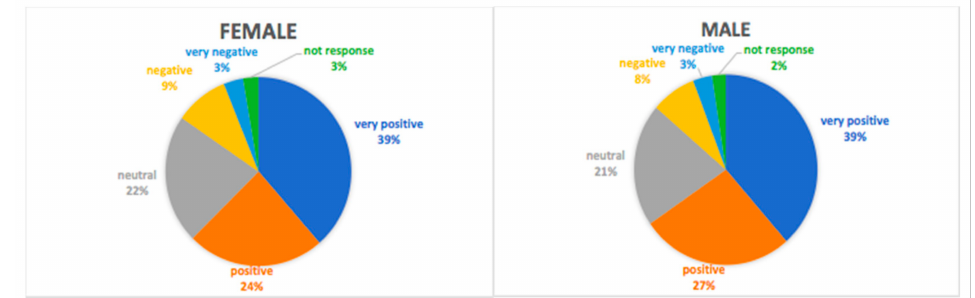
Figure 9. Results of the confidence dimension by gender.